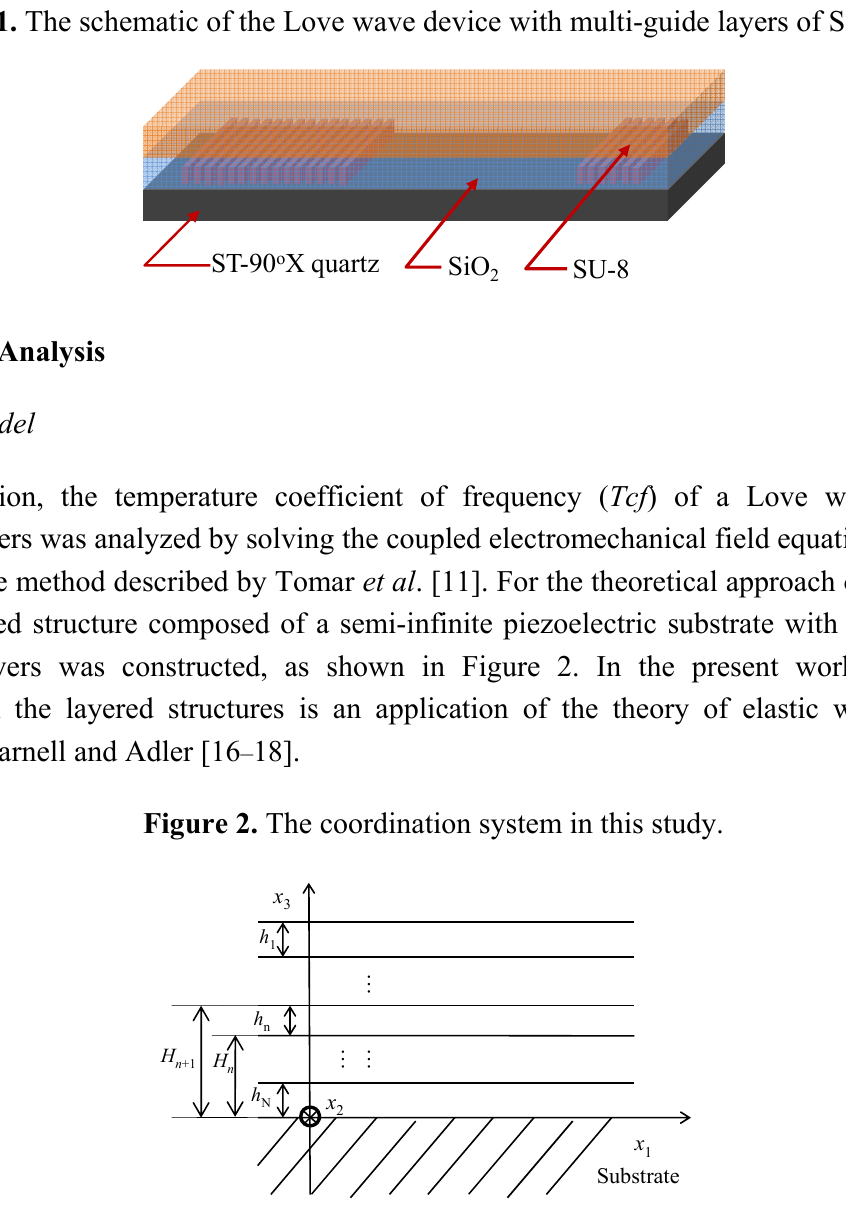
Figure 1. The schematic of the Love wave device with multi-guide layers of SiO